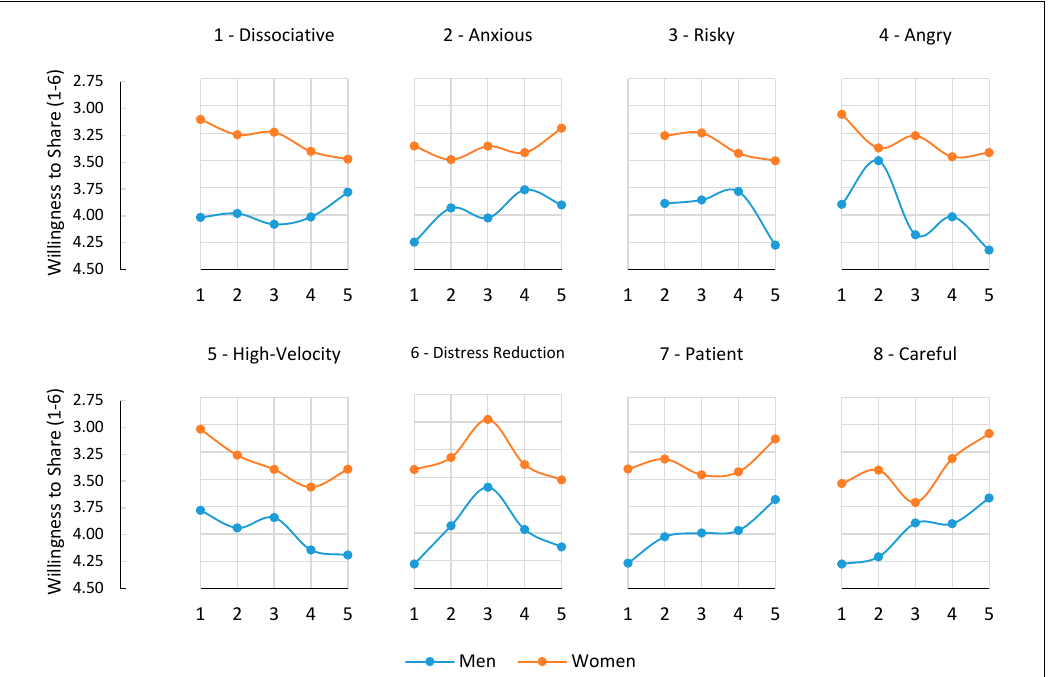
Figure 8. Impact on willingness to share information of driving style quintile (1–5) by gender.